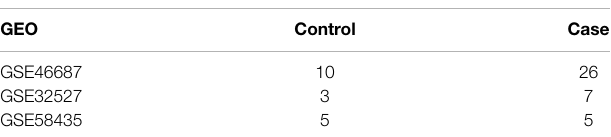
TABLE 1 | The basic clinical